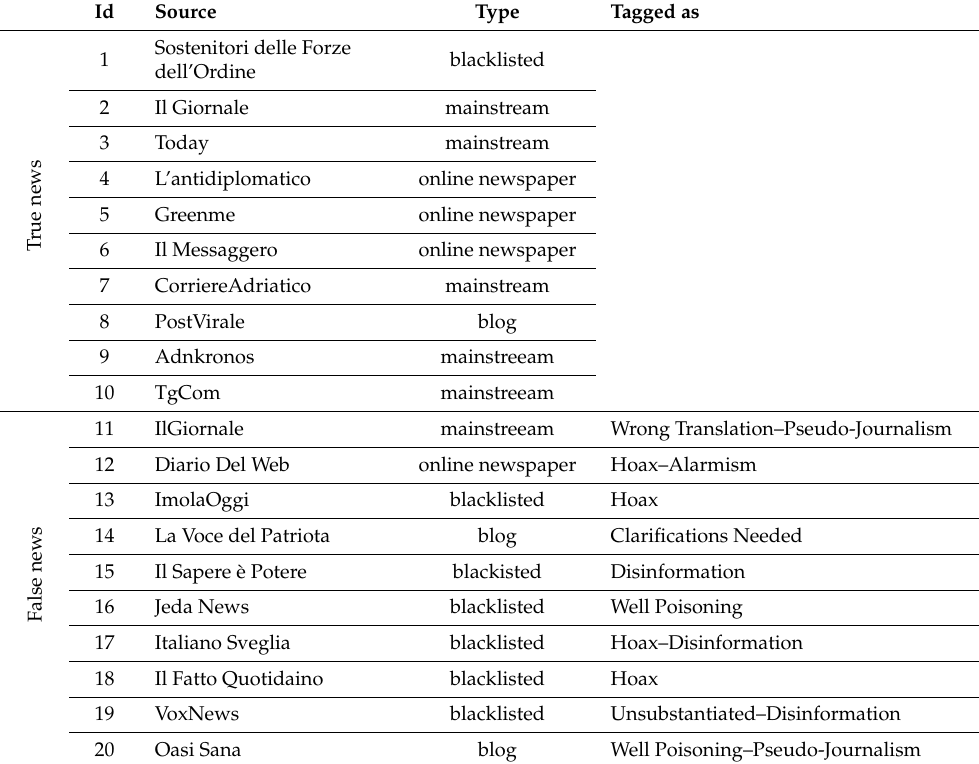
Table A2. Additional information regarding the articles. We show the sources for each article of Table A1; in fact, even if the same news could have been reported in more different news outlets, in Room 3, we showed only the source that published the article as it was presented to our volunteers. Moreover, we give here some more information, such as the type of the news outlet (i.e., mainstream, online newspaper, blog, or blacklisted by some debunking sites) and the tags used by fact-checkers upon correction. Such information was not explicitly disclosed to the